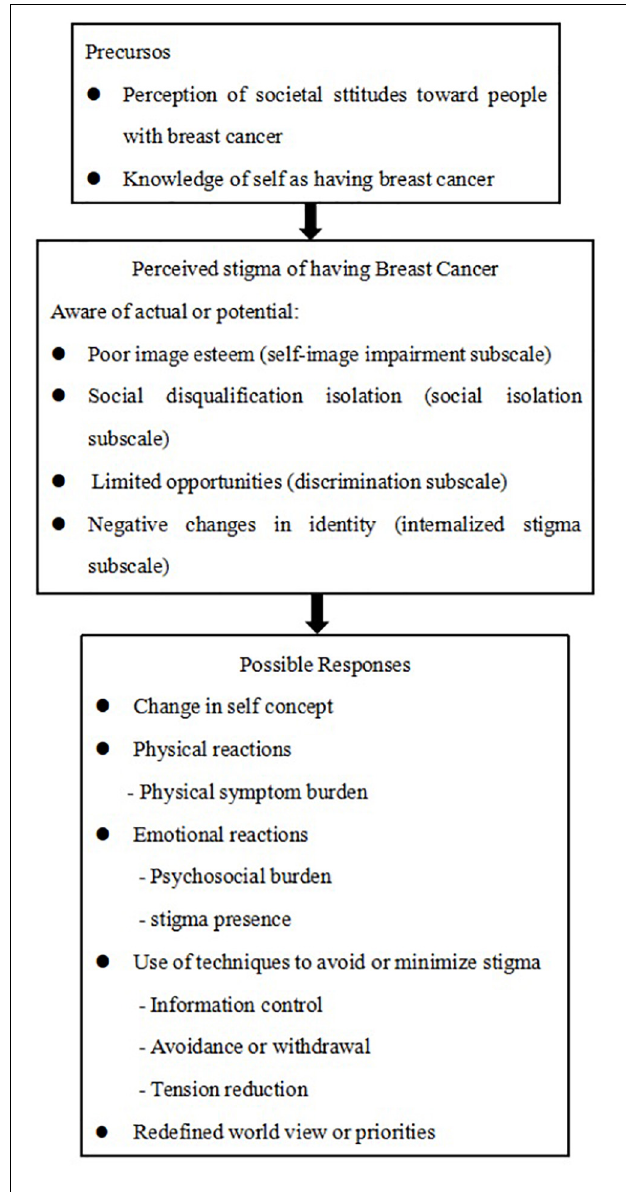
FIGURE 1 | A model of perceived stigma in patients with breast